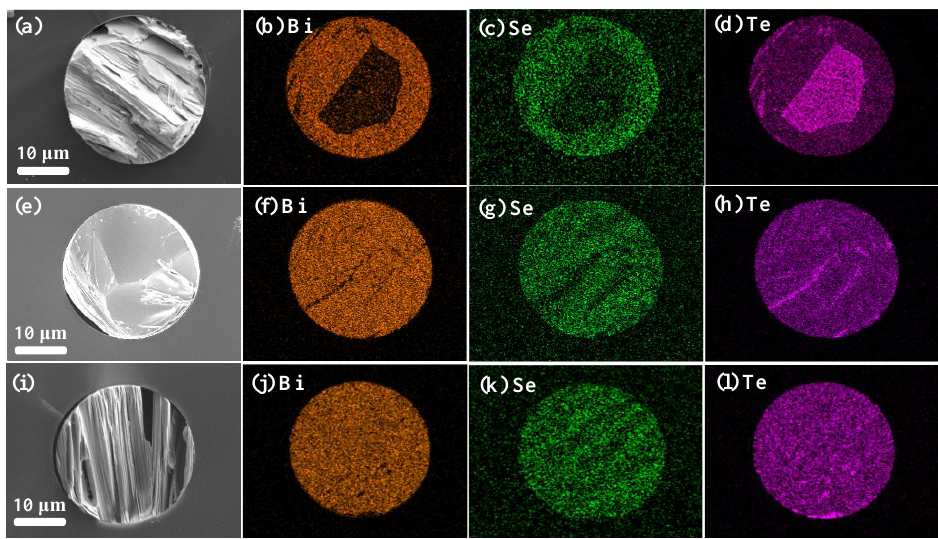
Figure 2. SEM cross-sectional images and EDS elemental mappings of ( a – d ) the as-drawn, ( e – h ) the whole-annealed, and ( i – l ) the Bridgman-annealed fibers.